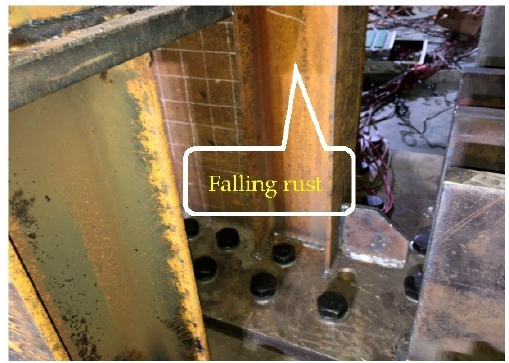
Figure 14. Falling rust at the web of column. At the twelfth loading level, the maximum reaction force of actuator forward loading was 740.8 kN with the measured displacement of 10.5 mm, and that of reverse loading was 753.9 kN with the displacement of 11.2 mm. The loading process was accompanied by a continuous giant sound and the maximum out-of-plane displacement at the center of the infill panel was 18.4mm, which indicated that the deformation was more conspicuous compared with the previous loading levels. Meanwhile, there was prominent peeling rust and tensile texture at the web of top beam. The deformation of the member is shown in Figure 15.